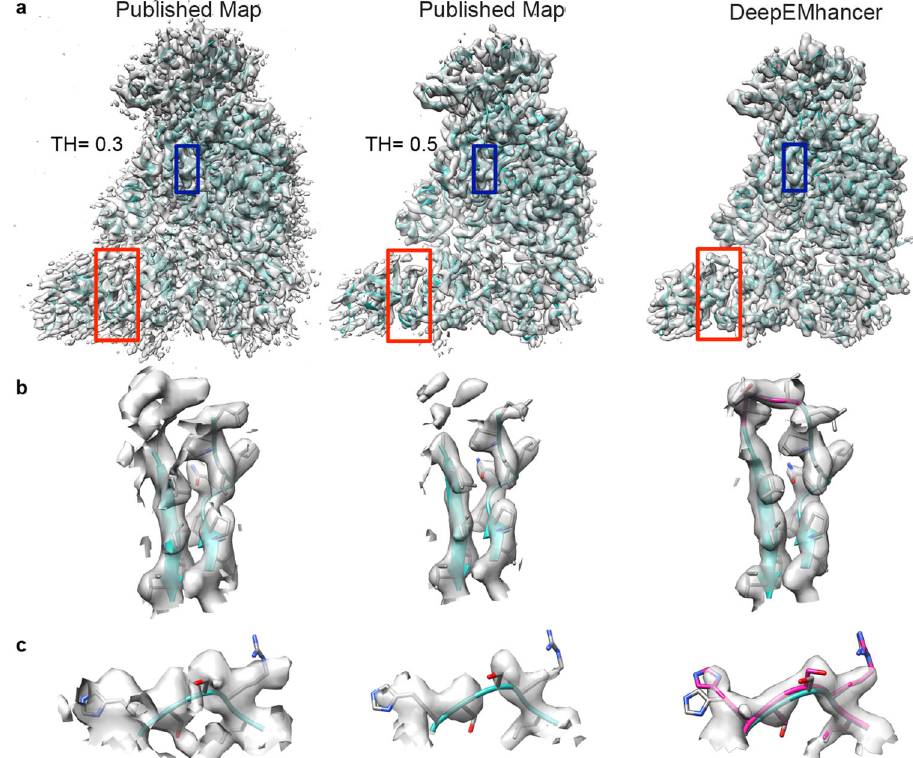
Fig. 6 Use case EMD-30178 from SARS-CoV-2 RNA-dependent RNA polymerase. a Overview of the published map displayed with two different thresholds 0.3 (recommended by the authors, left) and 0.5 (middle panel) and processed with DeepEMhacer (right). PDB 7btf is shown in ribbon, red squares designated the zoomed areas in b panel and blue squares the zoomed areas in c . b Zoom-in and extraction of the density from the 3D reconstruction of the published map at different thresholds and DeepEMhacer map corresponding to the red squares in a , chain D from residues V115 – I132. Newly traced residues in the DeepEMhancer map are shown in pink. c Zoom-in and extraction of the density from the 3D reconstruction of the published map at different thresholds and DeepEMhacer map corresponding to the blue